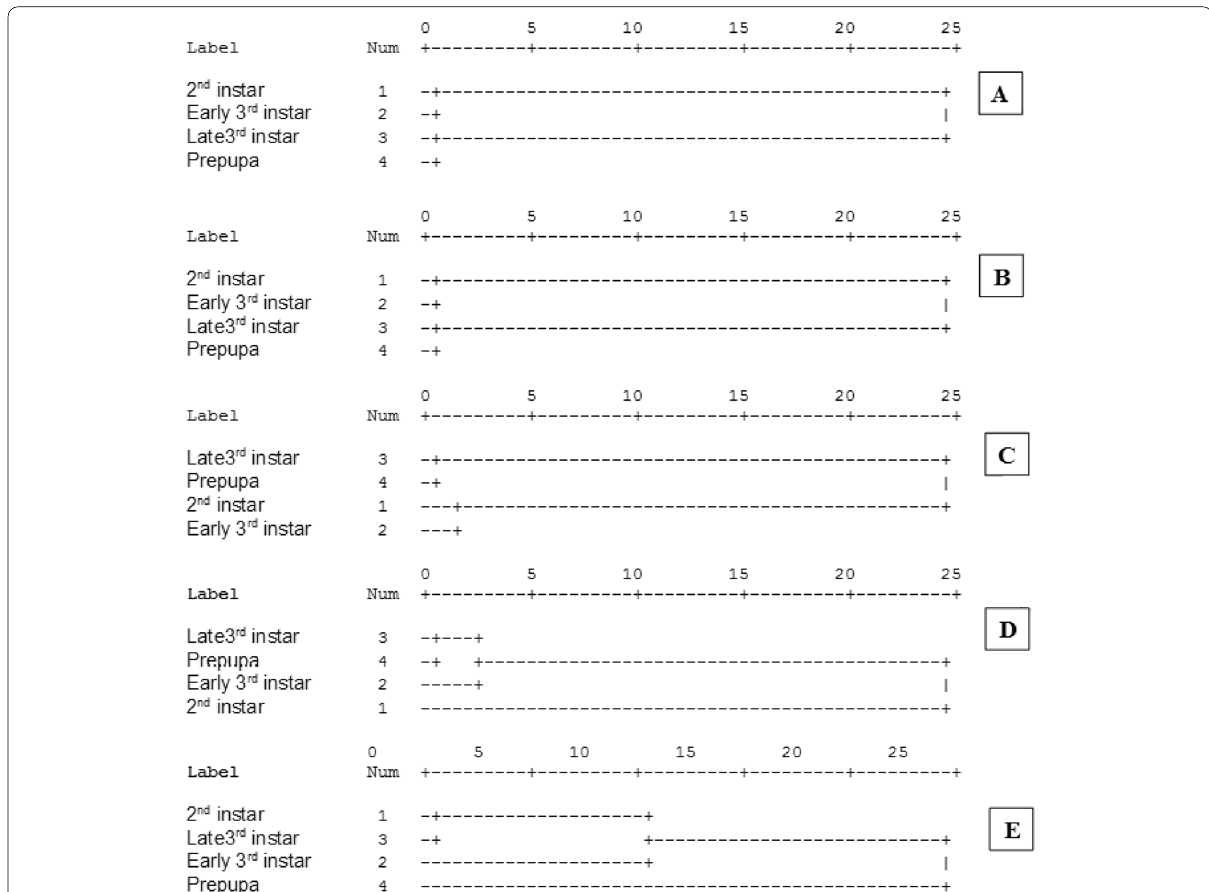
Fig. 5 Dendrogram of the cluster analysis (using Ward’s method) to evaluate the similarity effect between the developmental stages (second, early third, and late third larval instars and prepupa) of Sarcophaga argyrostoma , which fed on different clonazepam concentrations (25, 50, or 100 mg/ ml), and the ( A ) weight (mg), B length (mm), C width (mm), D concentration of clonazepam (mg/ml) in insect’s tissues using HPLC–MS, and ( E ) protein carbonyls amount in insect’s tissues using (OD/mg